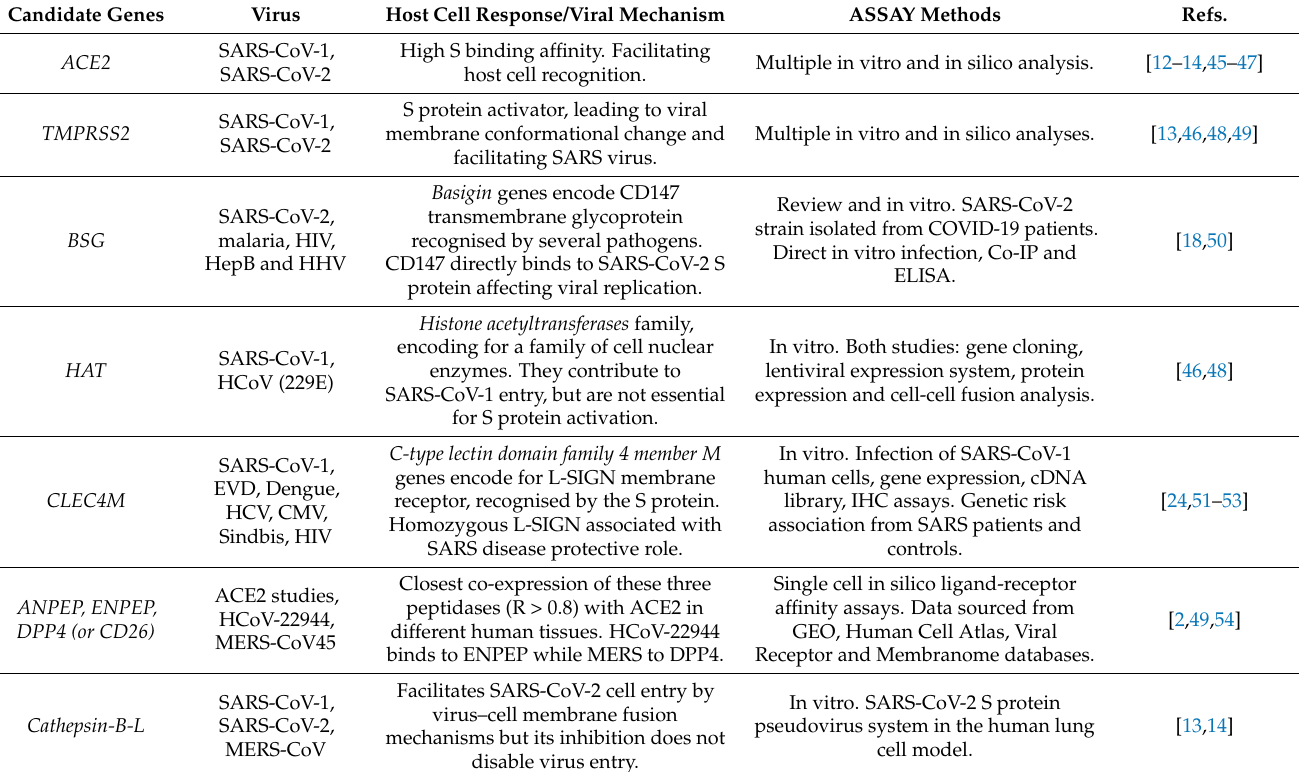
Table 1. Host cell candidate genes associated with the viral entry. Only those genes reported in more than one reference are depicted in this table. For the full list see Table